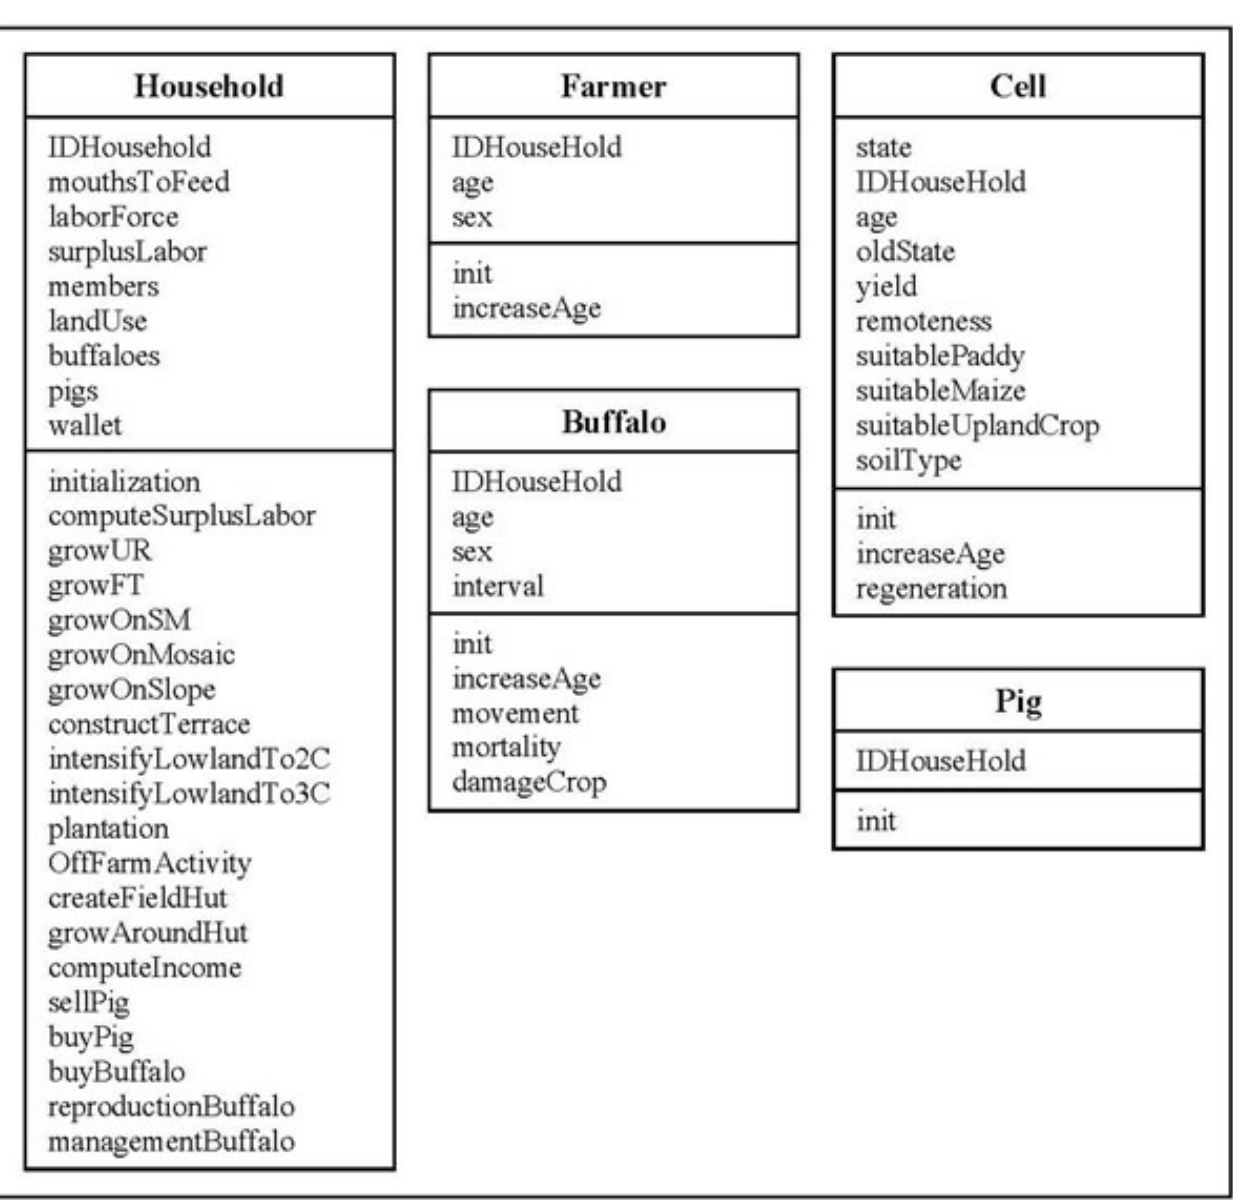
Fig. 4. The agent classes of the SAMBA model. The top box shows the attributes and the bottom box the methods associated with each entity (see Appendix